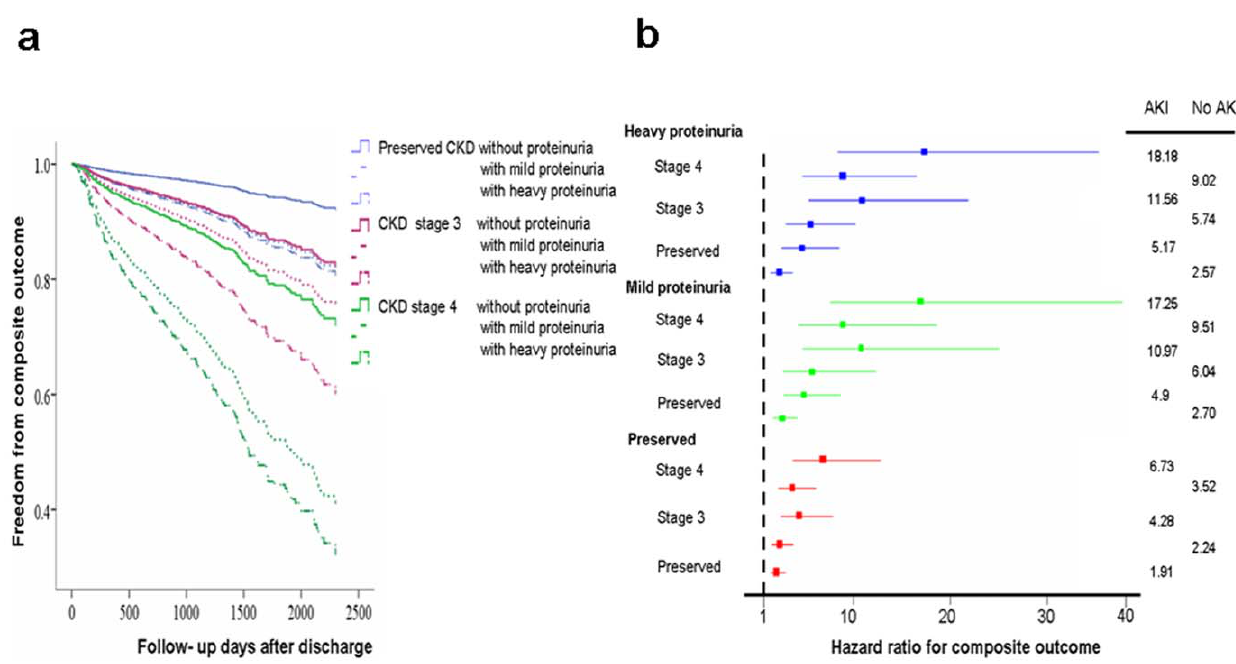
Figure 4. The composite outcome after hospital discharge (long- term end-stage renal disease or mortality) for urinary proteinuric categories across chronic kidney disease (CKD) categories using Cox proportional hazards regression (a) plot of freedom from composite outcome, * p , 0.05; ** p , 0.01; and *** p , 0.001 compared to patients with preserved eGFR and normal proteinuria. (b) Hazard ratio (HRs) stratified by proteinuria, baseline kidney function, and postoperative acute kidney injury (AKI) adjusted for factors listed in Table 1. The horizontal bars represent 95% CIs for HRs of participants who had proteinuria for various values of CKD stages and AKI.